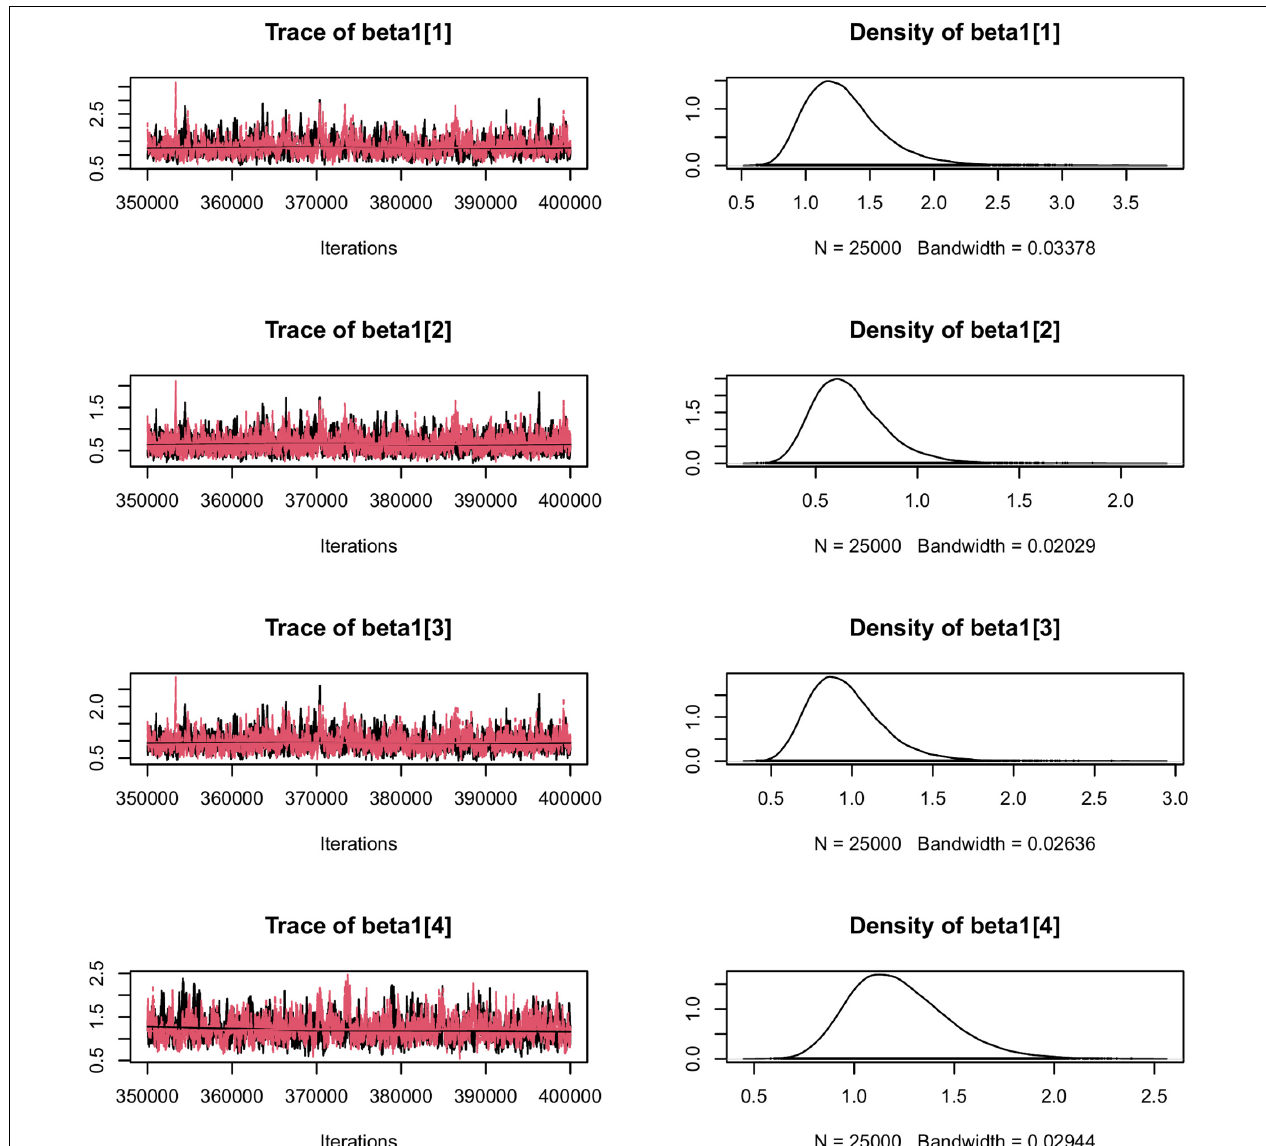
FIGURE 2 | The traces for model convergence and the posterior distributions of a portion of Model 2